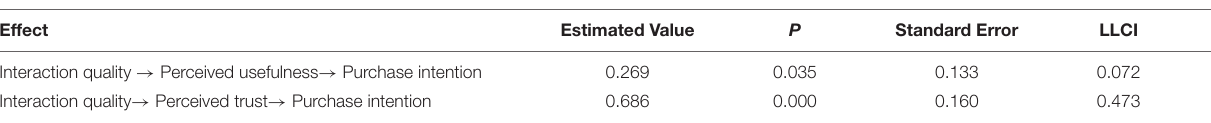
FIGURE 2 | Path coefficients of the hypothesized model. TABLE 4 | Mediating effect test.